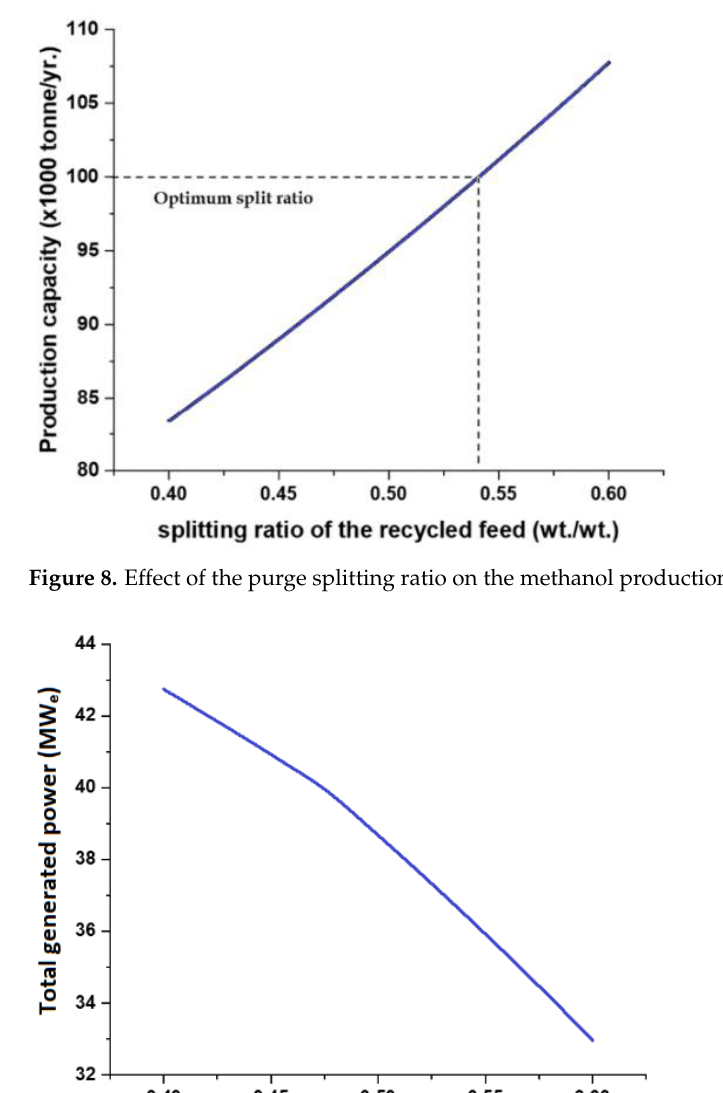
Figure 10. Distribution of the power generated by the equipment in the process.